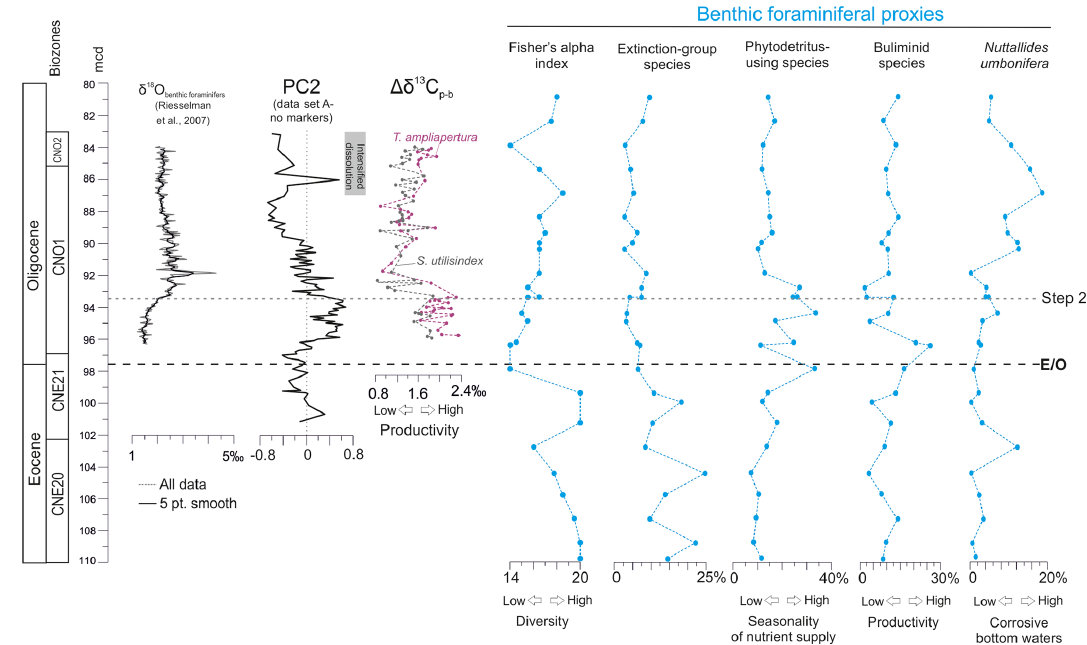
Figure 6. Paleoproductivity indices from nannofossil (PC2) and benthic foraminifer ( (cid:49)δ 13 C P-B calculated from data in Riesselman et al. (2007) and Peck et al. (2010); Fisher’s alpha index – diversity proxy, Extinction Group species, phytodetritus-using species, buliminid species and the species Nuttallides umbonifera ) datums are plotted against depth. The positions of EOB and Step 2 are reported.